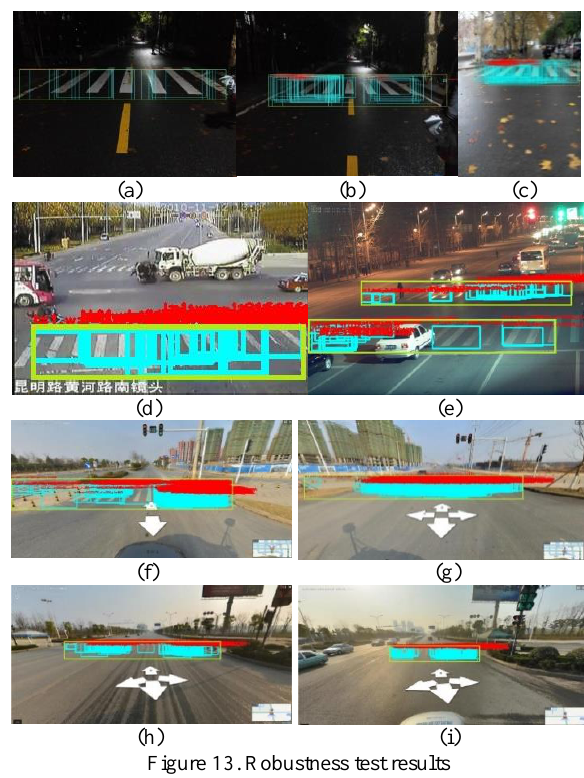
Figure 13. Robustness test results